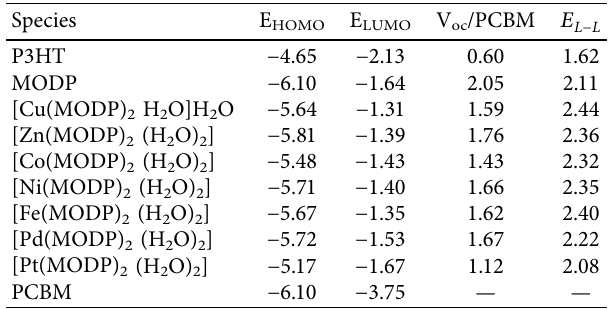
Table 5: HOMO, LUMO energy values (eV), and Voc/PCBM (eV) of the different molecules calculated at the DFT/PBE0-D3(BJ)/ def2-TZVP level of theory in the gas phase.